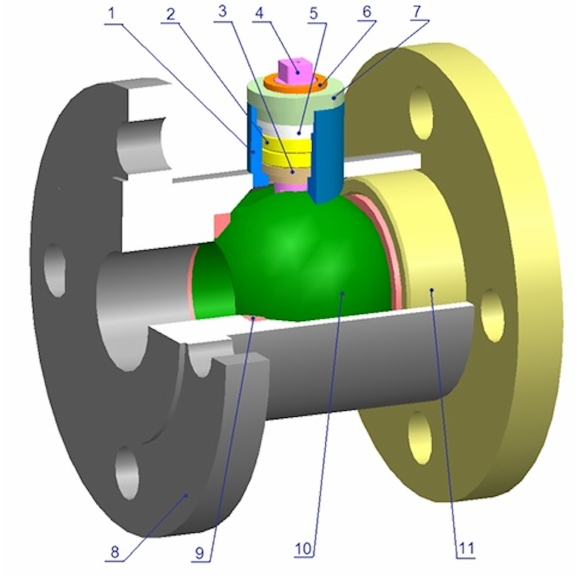
Figure 1: Construction of ball valve to be tested 1 – stuffing box, 2 – fabric ring, 3 – supporting ring, 4 – spindle, 5 – distance bushing, 6 – washer, 7 – screwed gland, 8 – housing with flange, 9 – PTFE seat, 10 – ball, 11 – locking sleeve with flange